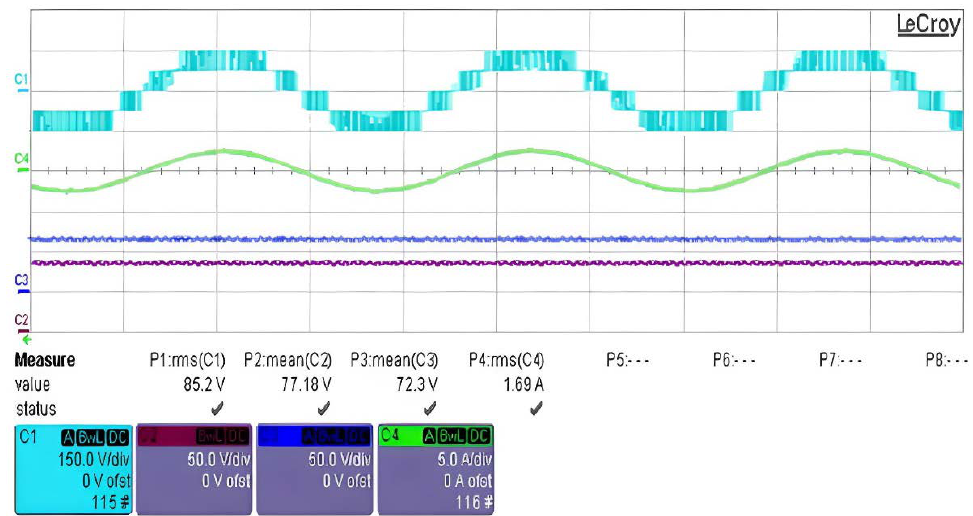
Figure 14. Experimental setup.